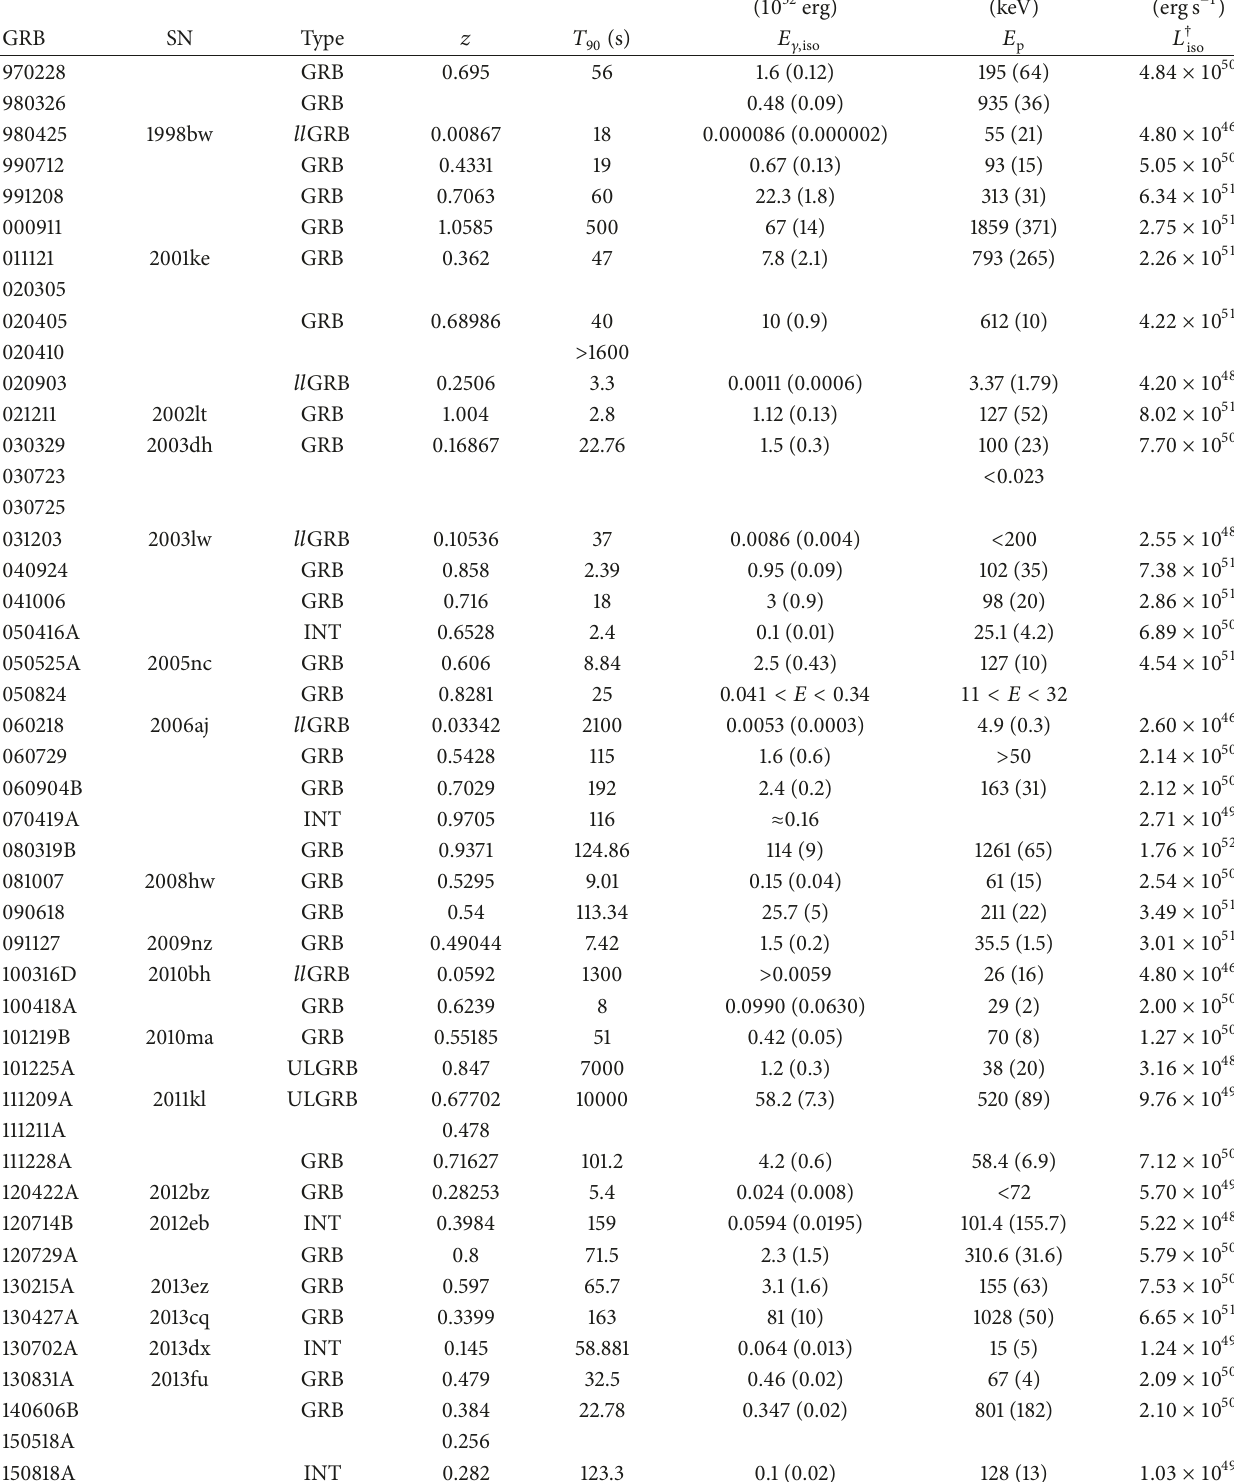
Table 2: GRB-SN master Table 1: 𝛾 -ray